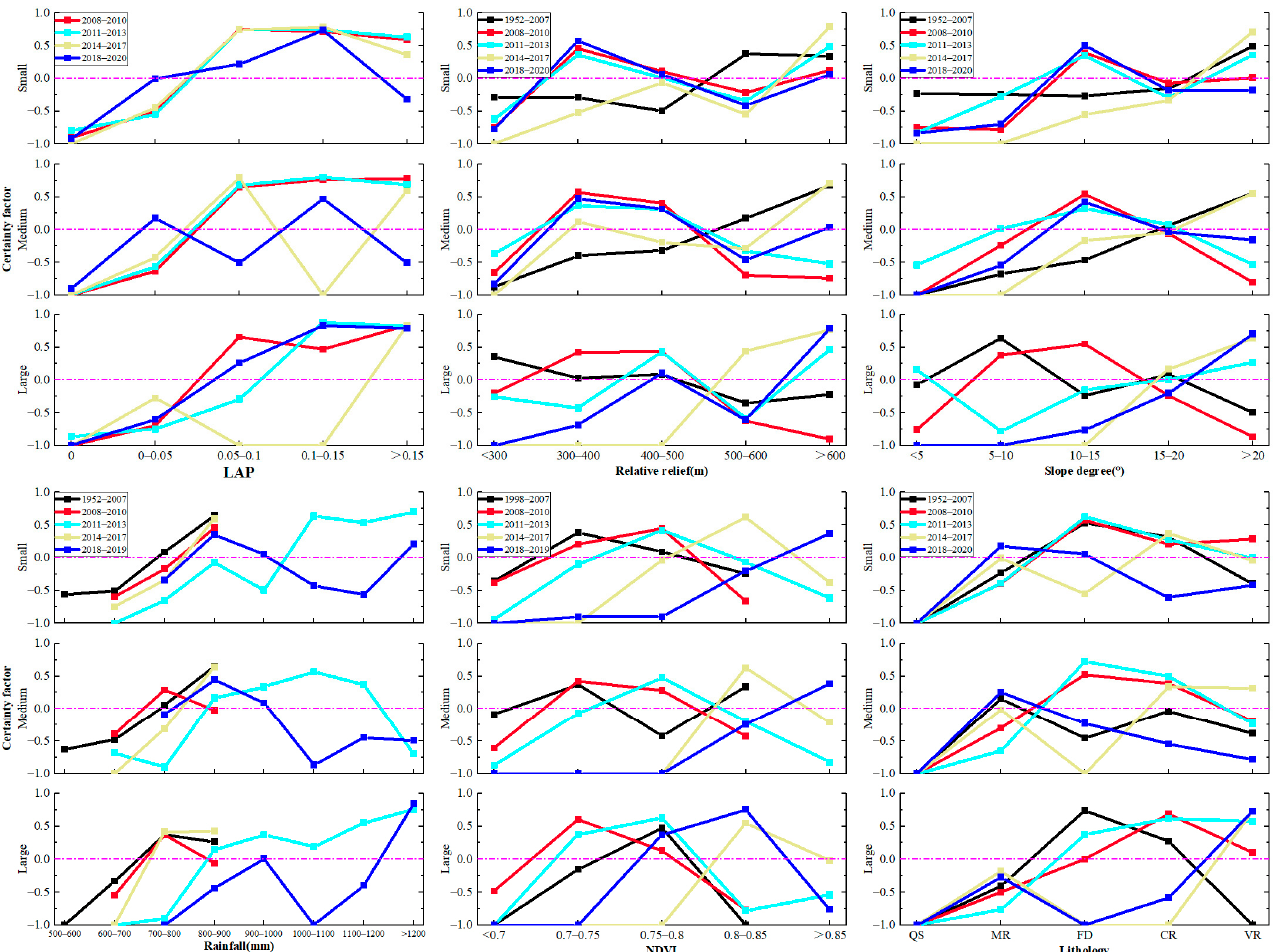
Figure 6. Evolution of the debris flow activity relating to controlling factors.